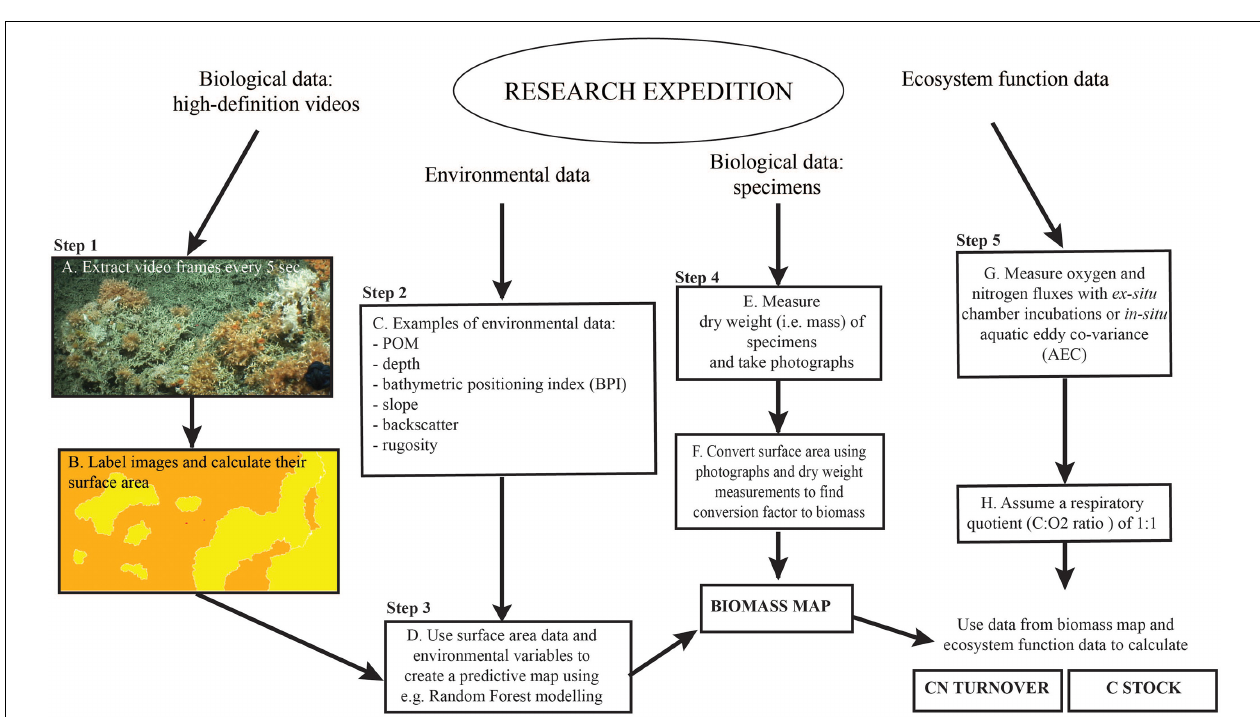
FIGURE 2 | (A) Globular, cauliflower-shaped L. pertusa colonies at the Mingulay Reef Complex sitting on a bed of dead framework and coral rubble, which is partially covered in white zoanthids. (B) Live pink, orange and white coral thickets of L. pertusa and Madrepora oculata at the Logachev Mound Province. The brown/beige colored framework is dead. Image credit: JC073 Changing Oceans Expedition 2012.